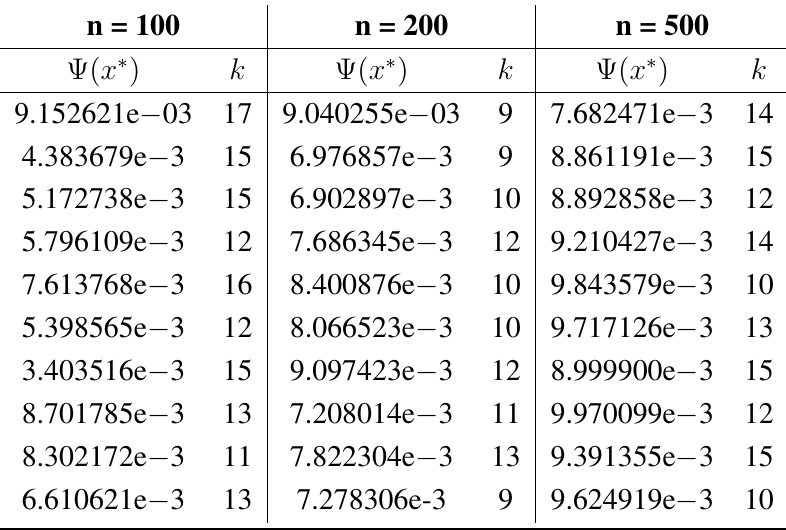
Table 11. Number of iterations, the final value of Ψ( x ∗ ) and dimension of the test